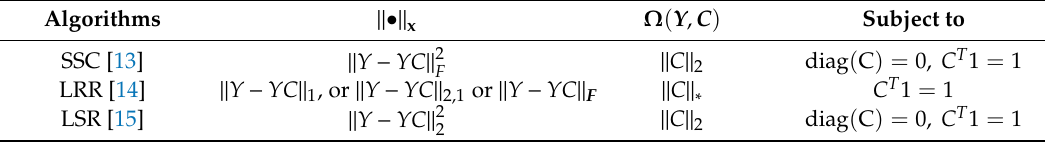
Table 1. The choices of (cid:107)•(cid:107) x and Ω ( Y , C ) of several existing representation-based algorithms.